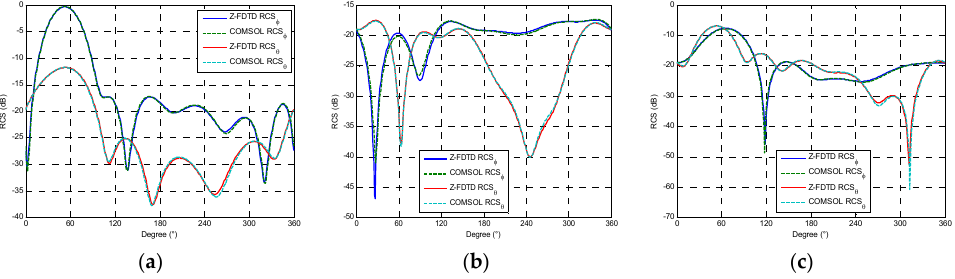
Figure 8. Time ‐ domain results of observation point E (0,0,0) when waves propagate through the Figure 8. Time-domain results of observation point E (0, 0, 0) when waves propagate through the multi ‐ layer spheres: ( a ) E x ; ( b ) E y ; ( c ) E z . multi-layer spheres: ( a ) E x ; ( b ) E y ; ( c ) E z .